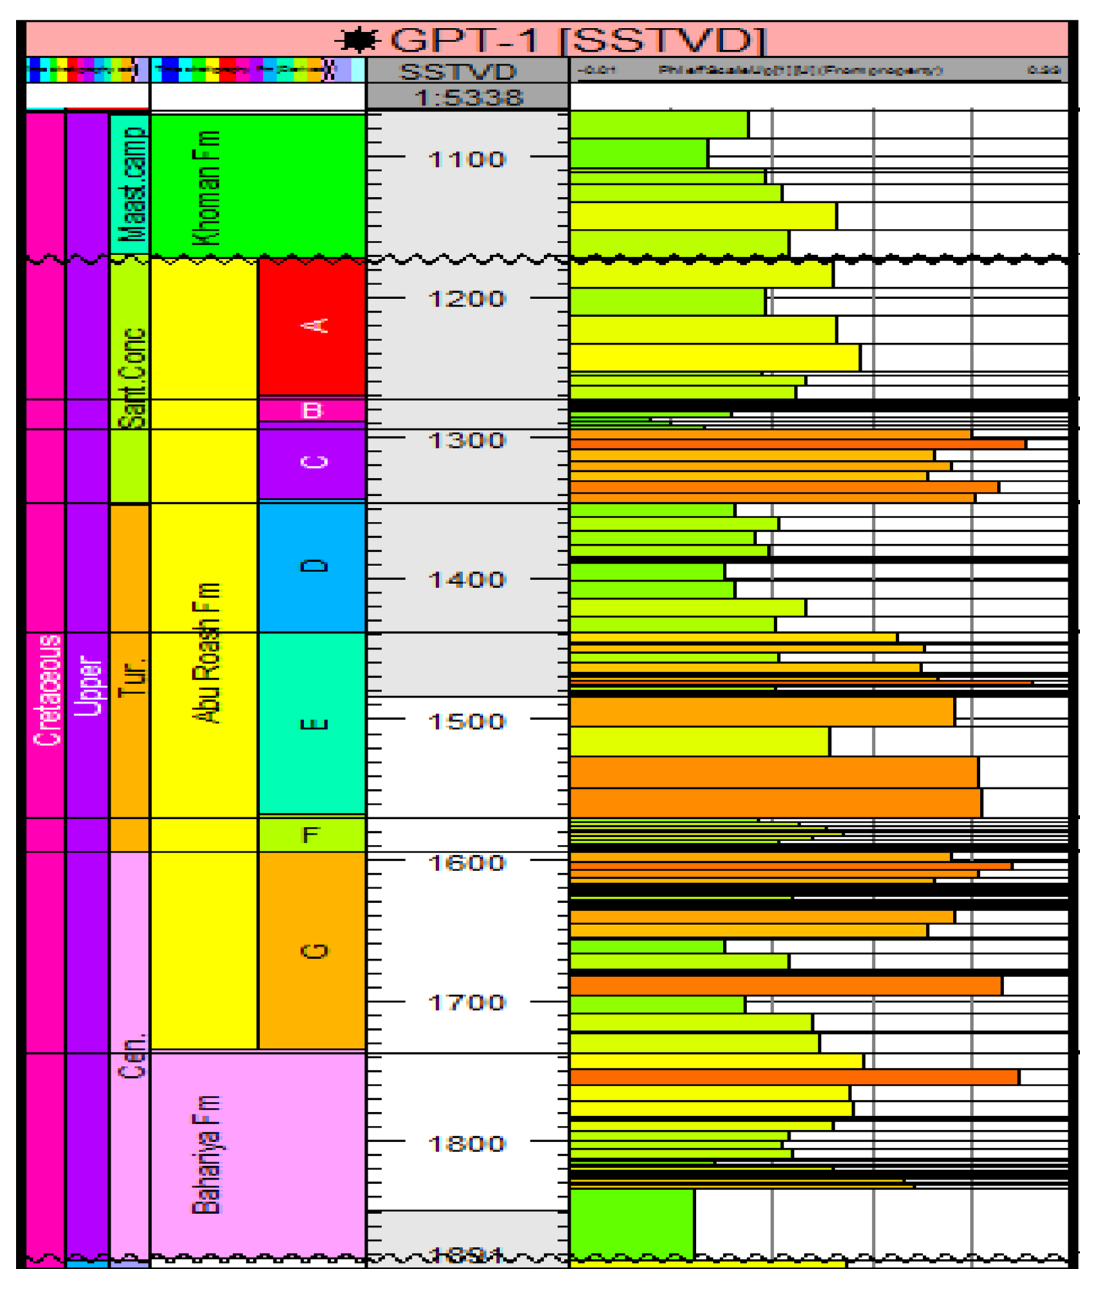
Fig. 15 Scale-up logs for the effective porosity modeling in GPT-1